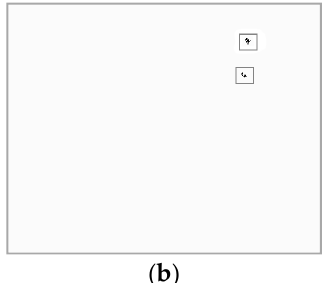
Figure 21. ( a ) A lateral image of the sphere surface; ( b ) Inspection result of Figure 21a.